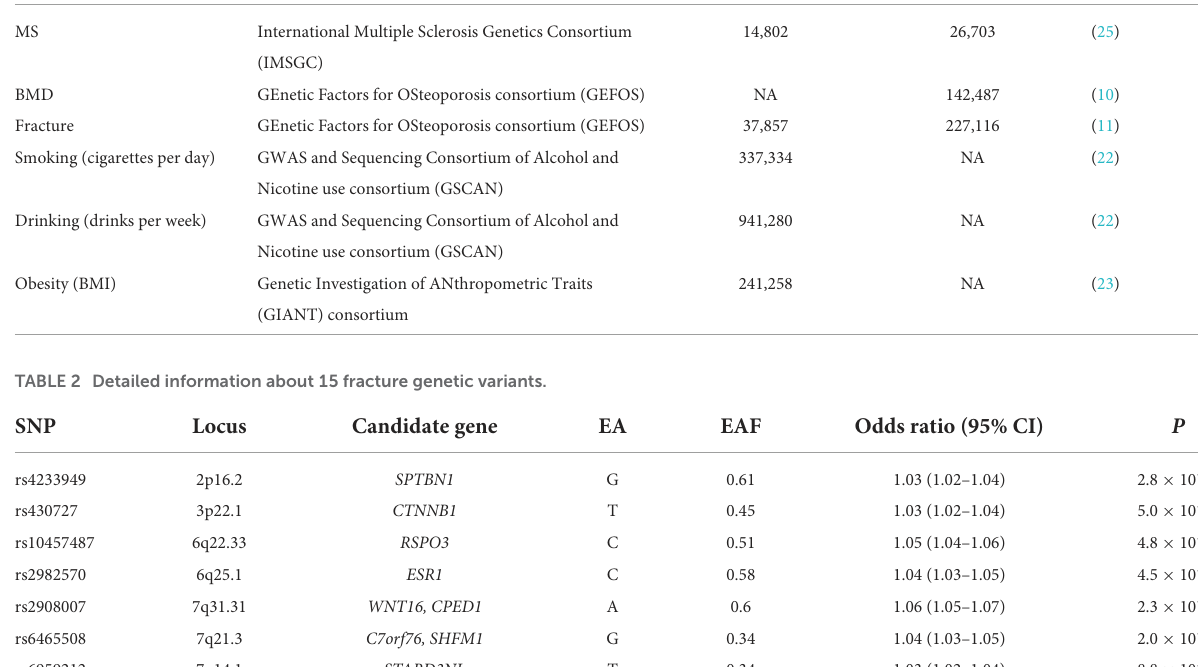
TABLE 1 Genome-wide association studies (GWAS) datasets selected in the current Mendelian Randomization (MR) study. GWAS datasets